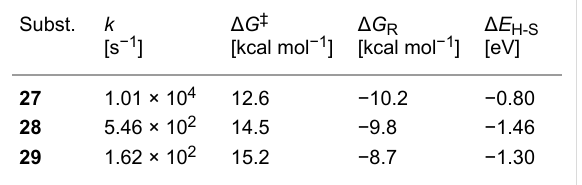
Table 6: Calculated kinetic and thermodynamic data (on the PW6B95- D3/QZVP//TPSS-D3/def2-TZVP level) and HOMO–SOMO gap Δ E H-S (on the TPSS-D3/TZVP level) of the reactions of 27 – 29 in benzene at 40 °C.